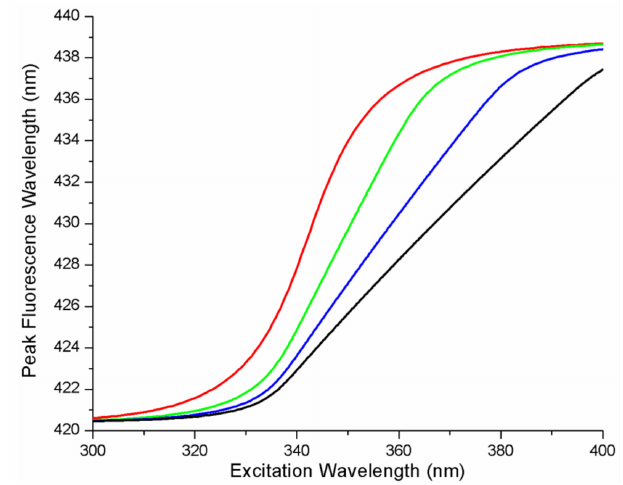
Figure 4. REES curves for a quadratic energy landscape (b = 2) as a function of the number of microstates, N. Plots from left to right represent the influence of increasing the number of microstates, N, on the REES curves (N = 5, N = 10, N = 15, N = 20). All other parameters were fixed (b = 2, A = 0.0025 eV, x GS = 0.15). The photo-physical parameters for the ligand, L, were fixed ( x CT = 0.89, κ = 1, ∆ CTGS0 = 3.346 eV, ∆ G CTGSN = 3.223 eV). Plots were generated with the specified